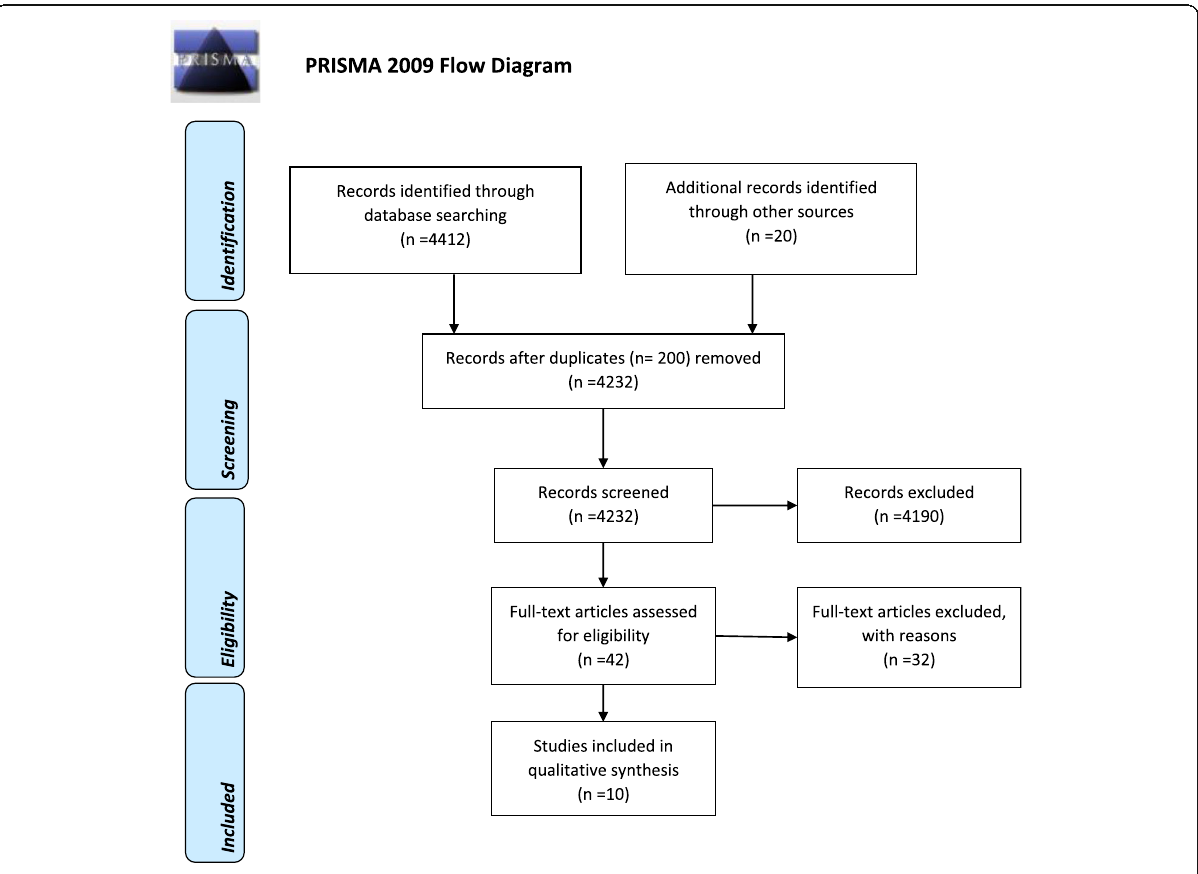
Fig. 1 PRISMA 2009 flow